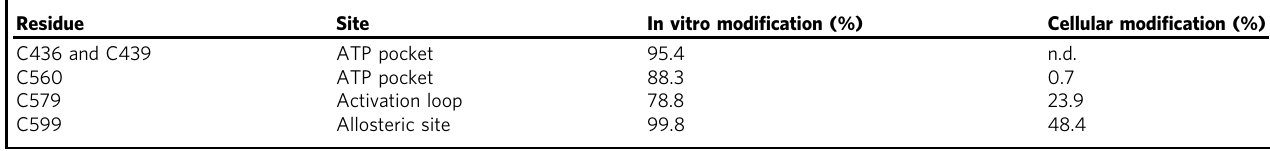
Table 1 Degree of in vitro modi fi cation of cysteines in RSK2 CTKD by DMF on puri fi ed RSK2 CTKD (DMF1 mM) and in HEK293 cells (DMF 140 µ M) estimated by mass spectrometry ( n = 1) Residue Site In vitro modi fi cation (%)